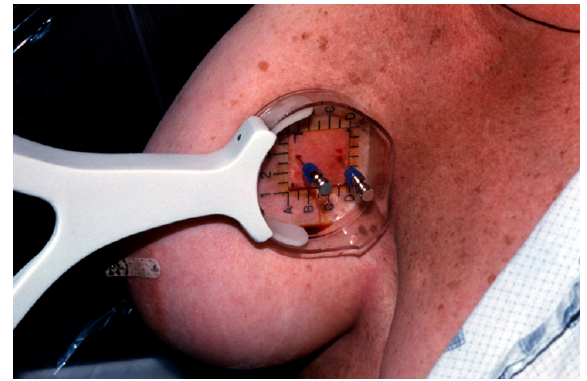
Figure 6. Mammographically-guided SLNB with two spinal needles.